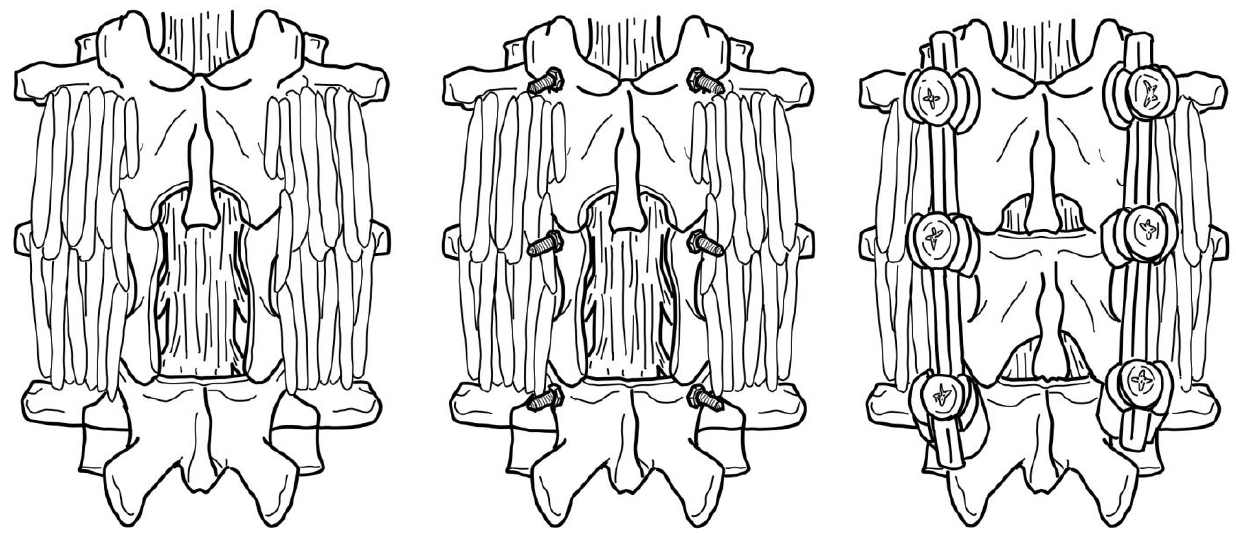
Figure 6. Schematic of laminectomy protocol. Added metal instrumentation enhances spinal stability and improves outcomes following surgery [84].